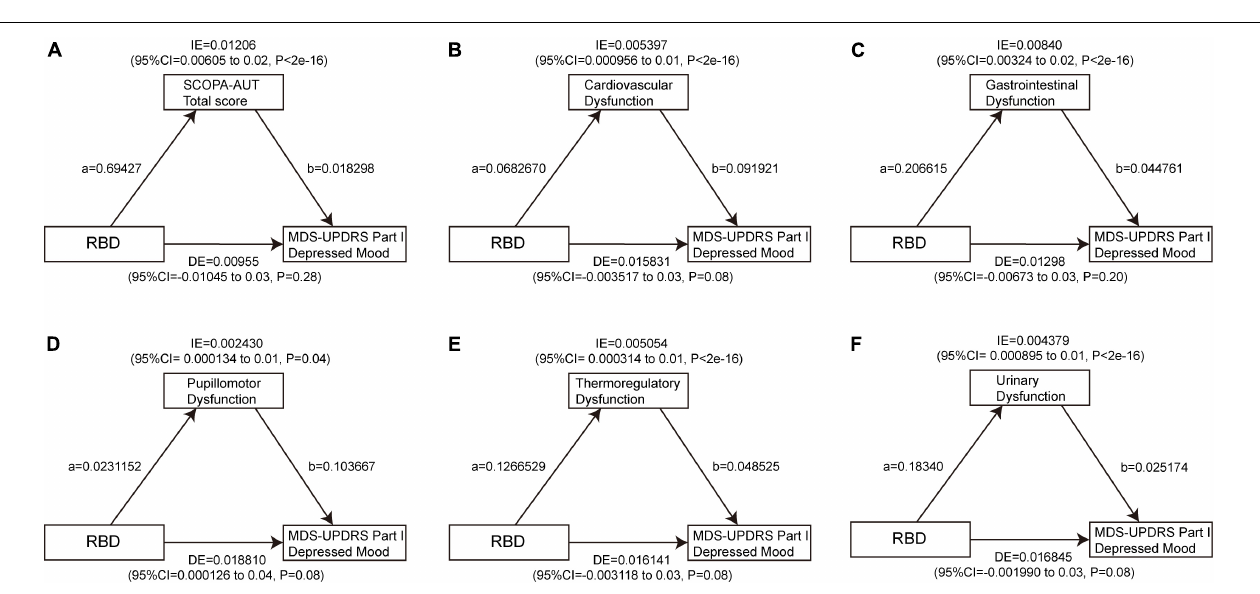
FIGURE 6 | Autonomic dysfunctions mediate the effects of RBD on GDS. The significant mediating effect of RBD on GDS through the SCOPA-AUT total score (A) , cardiovascular dysfunction (B) , gastrointestinal dysfunction (C) , thermoregulatory dysfunction (D) , and urinary dysfunction (E) at baseline. Path a indicates the direct effect of RBD on autonomic symptoms. Path b indicates the direct effect of autonomic symptoms on depression. GDS, Geriatric Depression Scale; RBD, rapid eye movement sleep behavior disorder; SCOPA-AUT, Scales for Outcomes in Parkinson’s Disease-Autonomic.